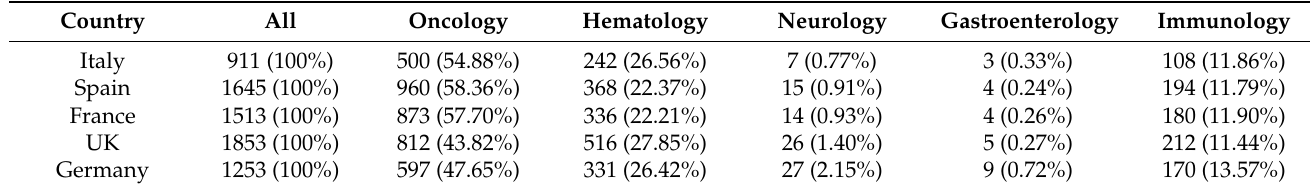
Table 2. Therapeutic areas distribution among phase 1 clinical trials. The total number of reg- istered phase 1 clinical trials on ClinicalTrials.gov was divided by country and therapeutic